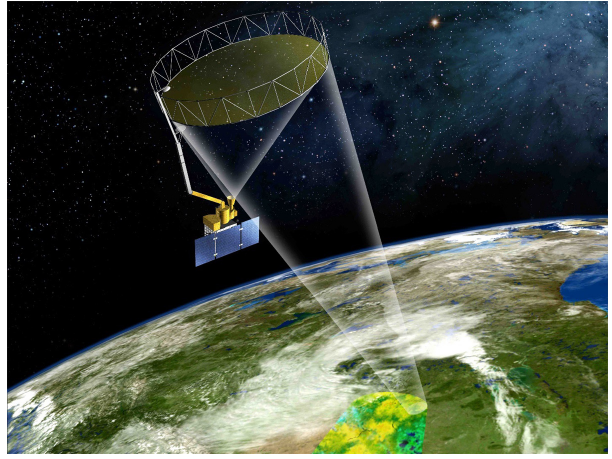
Figure 1. An artist’s rendering of SMAP observations from orbit. Image credit: NASA Jet Propulsion Laboratory (JPL) https://smap.jpl.nasa.gov/resources/59/smap-taking-data-from-orbit, Date Ac- cessed: 15 May